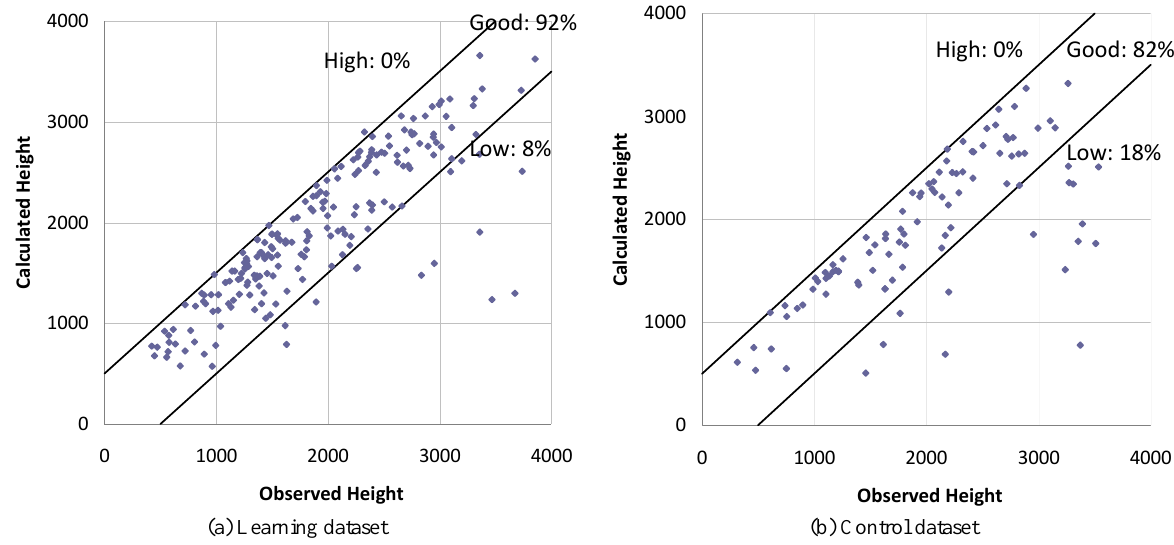
Fig. 4. Performance of the algorithm (Eq. 10, 19) for the free-troposphere plumes extracted from the learning (panels a ) and control (panels b ) MISR datasets. Unit = [m].